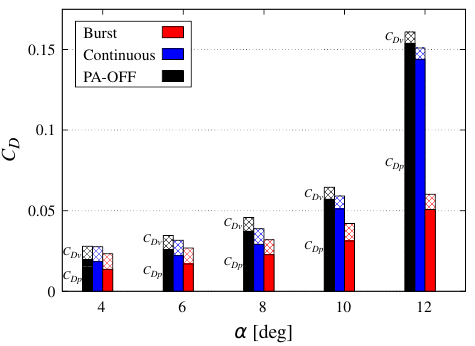
Figure 8. Pressure drag coefficient ( C D